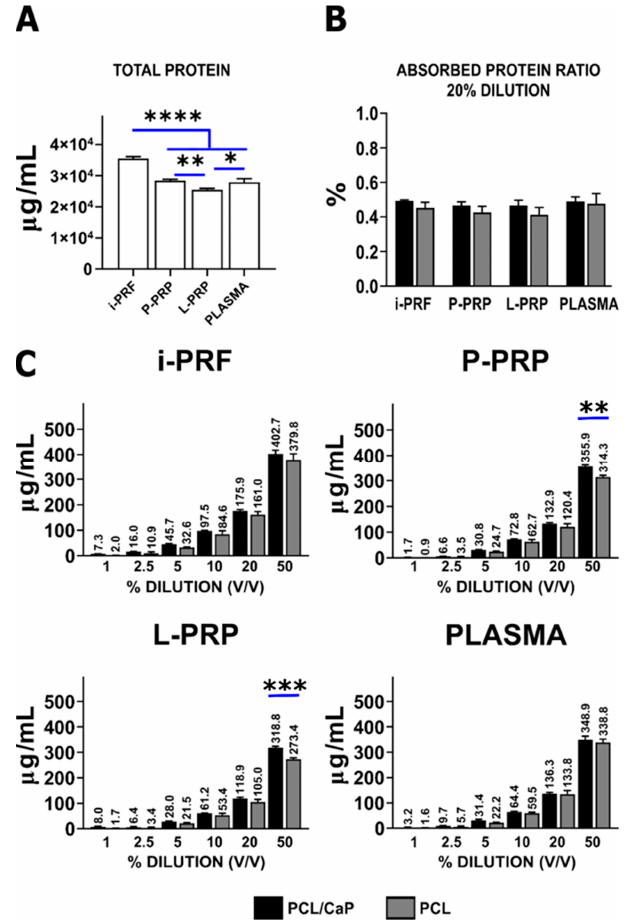
Figure 3. ( A ) Total protein quanti fi cation for each hemoderivative. ( B ) At 20% dilution, no statistically signi fi cant di ff erences were found between the hemoderivatives applied on CaP sca ff olds. ( C ) Hemoderivative protein adsorption at di ff erent dilutions showing statistically signi fi cant starts over time with increasing dilution in P-PRP and L-PRP. Other